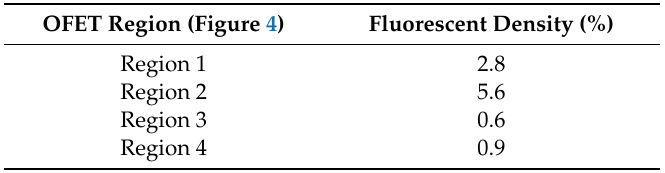
Table 1. Fluorescent density (%) for the different OFET micrographs.